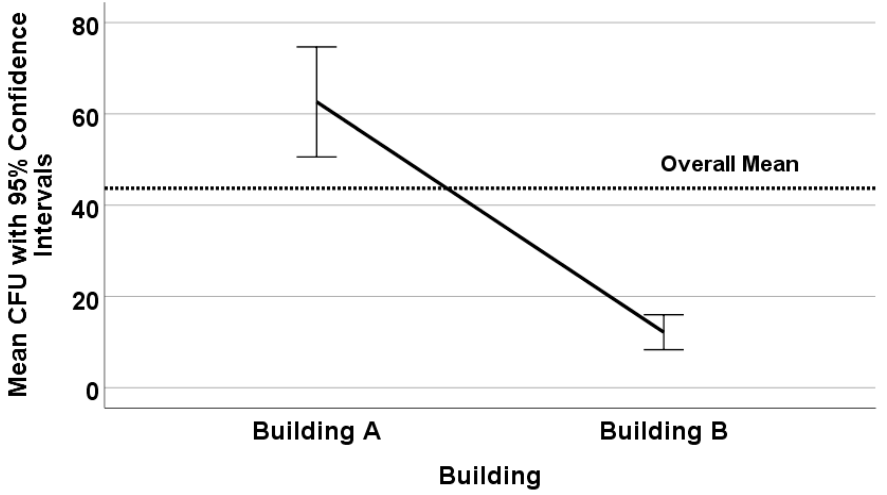
Figure 1. Mean Legionella counts (colony forming units per milliliter (CFU/mL)) as a function of